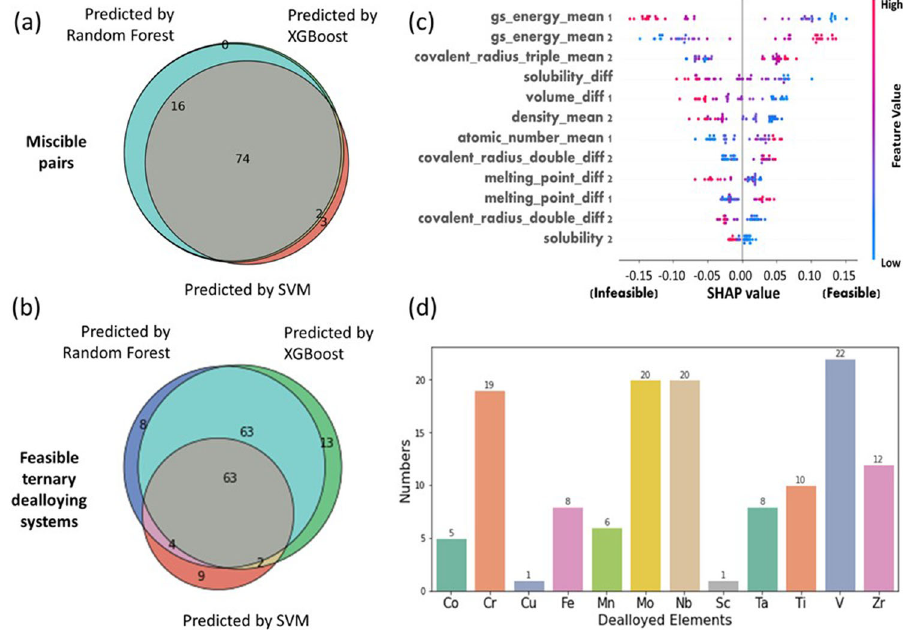
Fig. 3 The ML prediction result and corresponding SHAP value analysis. a The overlap of the miscible and immiscible pairs predicted by the three ML methods, namely random forest, XGBoost, and SVM. b The overlap of predicted ternary dealloying systems from the three ML methods. c The 12 variables which are ranked by their impacts on differentiating the dealloying agent from the parent alloy, as sorted by the random forest method. Variables ending with 1 represent the properties of the fi rst two elements in a ternary system, and those ending with 2 represent the properties of the last two elements. d The number of predicted ternary dealloying systems organized by element A, where the parent alloy is A-B. The results are voted higher by at least two ML methods. Table 1 Description of the fi nal 12 most important variables selected by three ML methods, using for determining parent alloy (Step